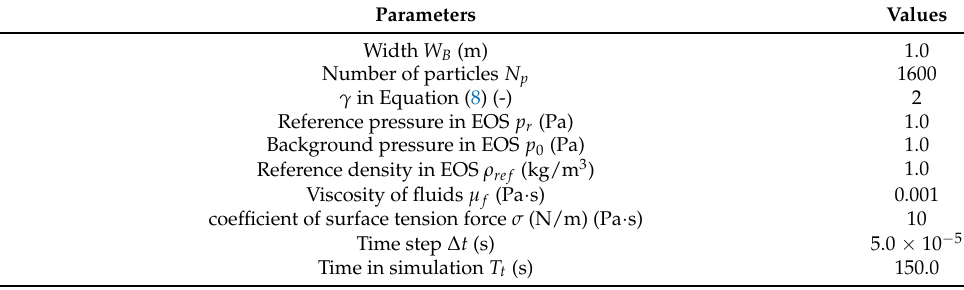
Table 1. Parameters of used in the case of a square bubble in a single-phase